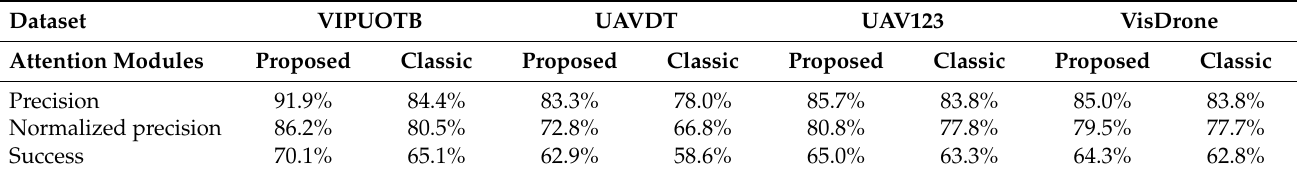
Table 8. The comparison results of utilizing different attention